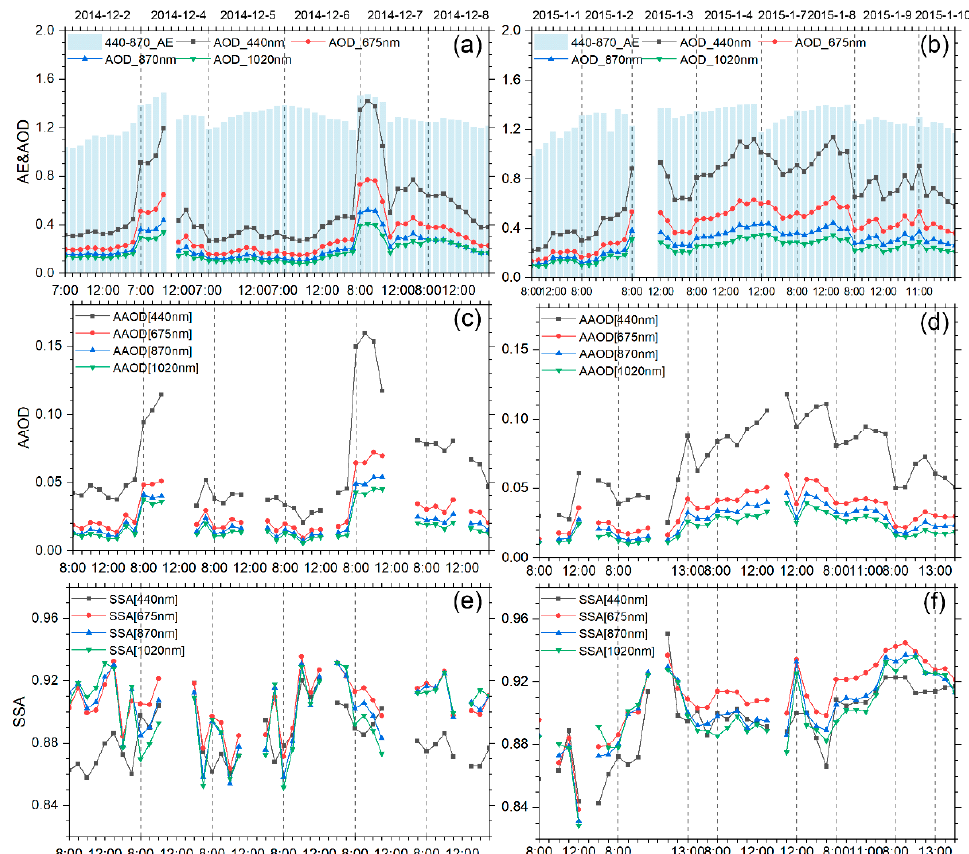
Figure 4. Ångström exponent at 440–870 nm (AE440–870 nm) and aerosol optical depth at 440 nm, 675 nm, 870 nm, and 1020 nm (AOD440 nm, AOD670 nm, AOD870 nm, and AOD1020 nm) ( a , b ), aerosol absorption optical depth at 440 nm, 675 nm, 870 nm, and 1020 nm (AAOD440 nm, AAOD670 nm, AAOD870 nm, and AAOD1020 nm) ( c , d ), and single scattering albedo at 440 nm, 675 nm, 870 nm, and 1020 nm (SSA440 nm, SSA675 nm, SSA870 nm, and SSA1020 nm) ( e , f ) during 02 to 08 December 2014 ( a , c , e ) and 01 to 10 January 2015 ( b , d , f ) (China Standard Time (CST)).